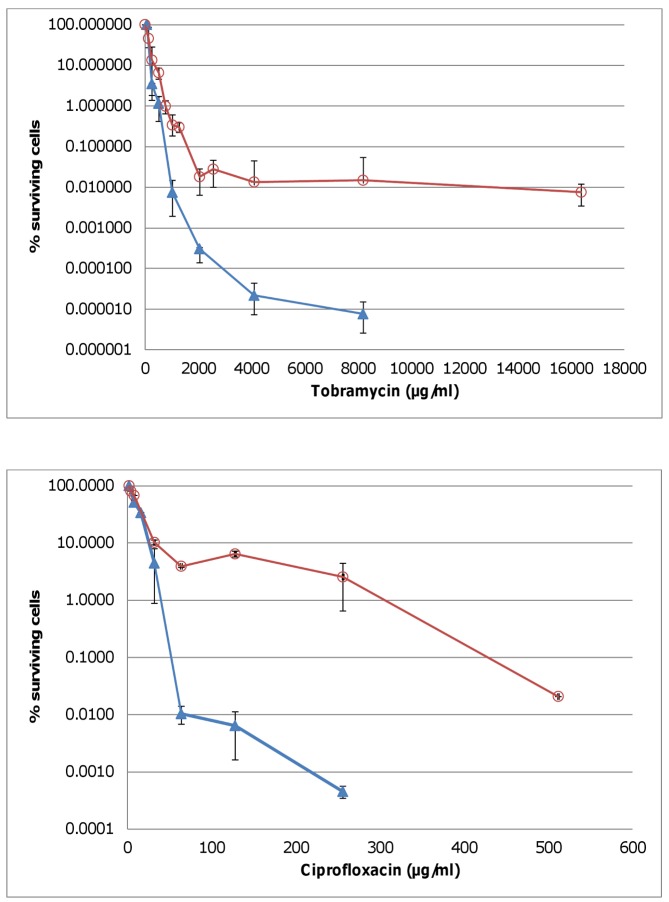
The percentage surviving cells after treatment of B. cenocepacia J2315 with tobramycin or ciprofloxacin.The results from the biofilm experiments are indicated with open circles and those from the planktonic cultures with triangles. Error bars represent min-max (n ≥2).